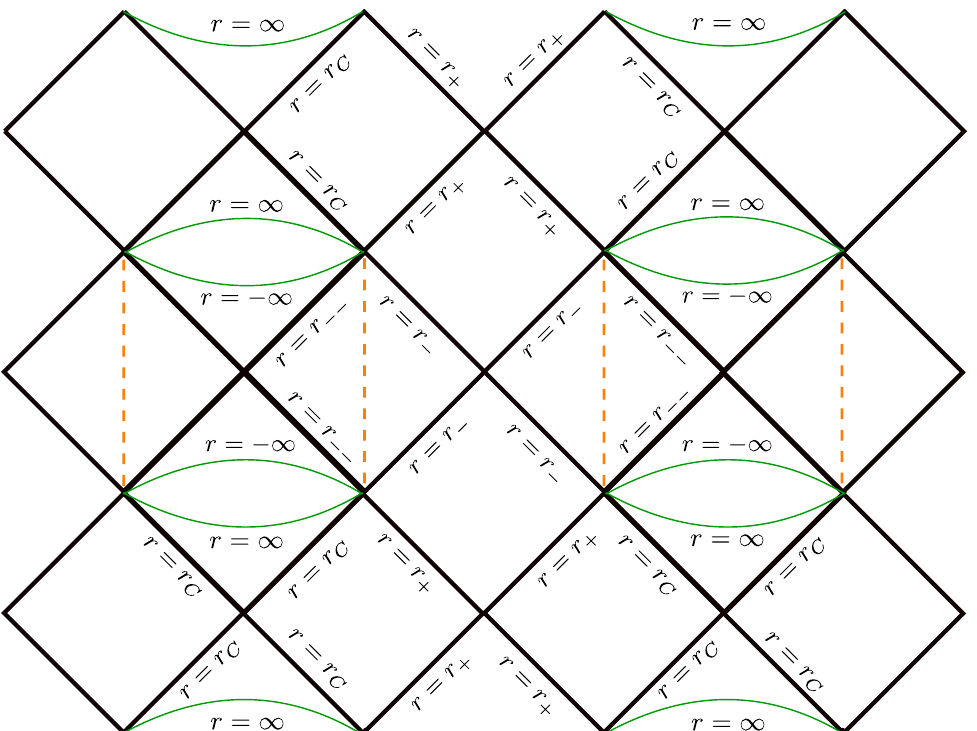
Figure 1 . Kerr-de Sitter causal diagram for (cid:18) = 0. The ring-like singularity at r = 0 ; (cid:18) = (cid:25)= 2 is denoted by the orange dashed lines.